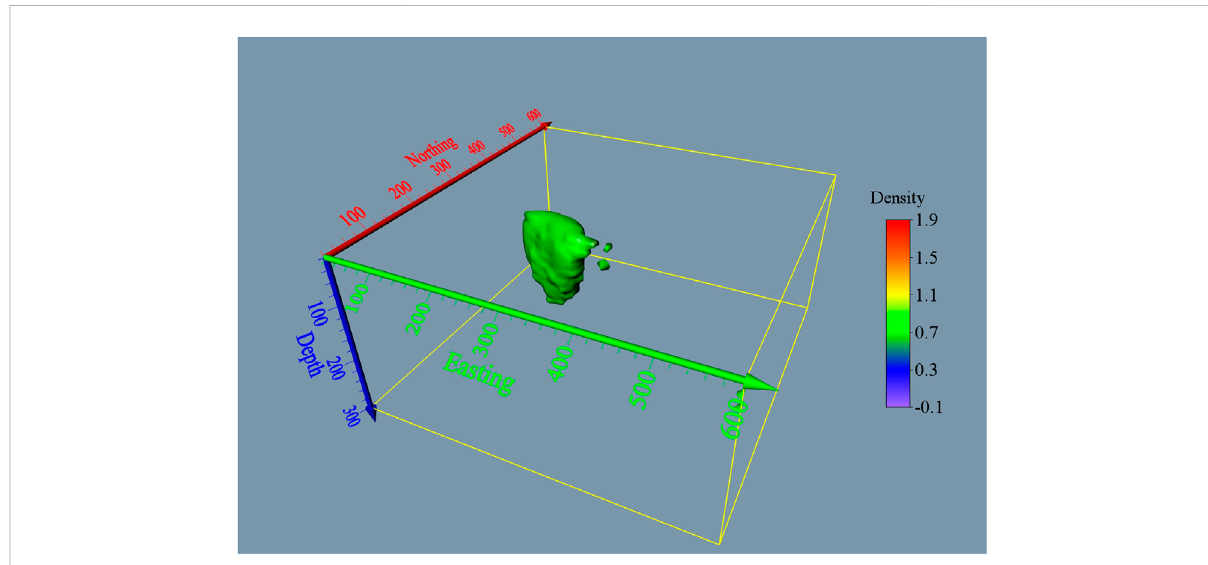
FIGURE 12 3D view of the inversion density of the Mobrun ore body for a cut off density of 0.8 g/cm 3 .